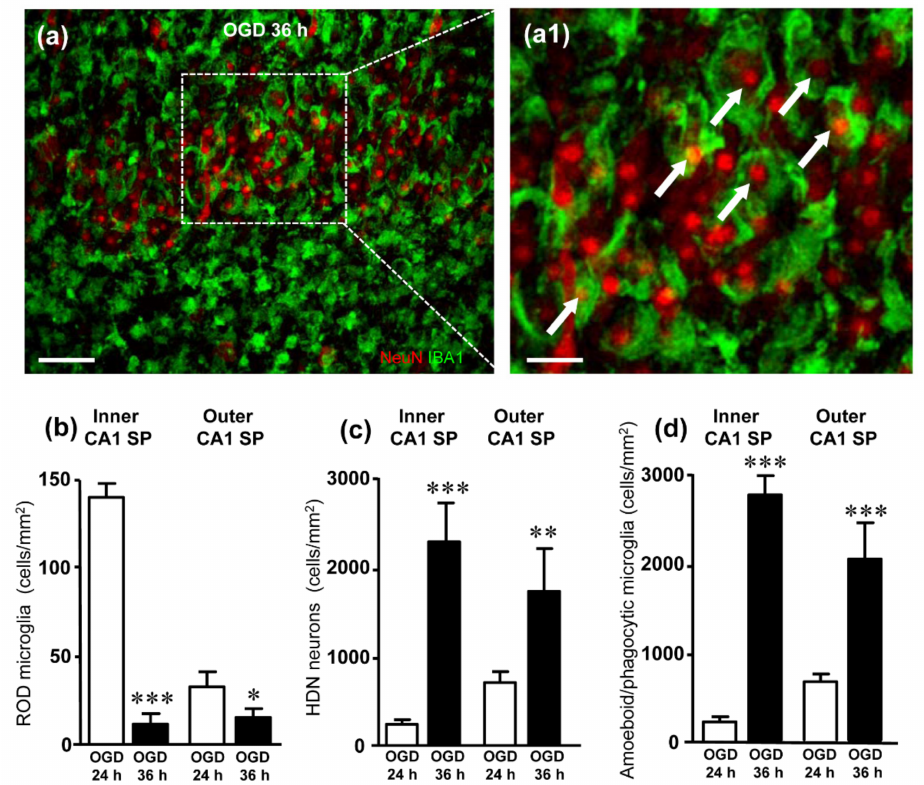
Figure 6. ( a ) Representative confocal images of NeuN-positive neurons (red) and IBA1-positive microglia (green) in CA1 hippocampus of an OGD organotypic hippocampal slices, harvested 36